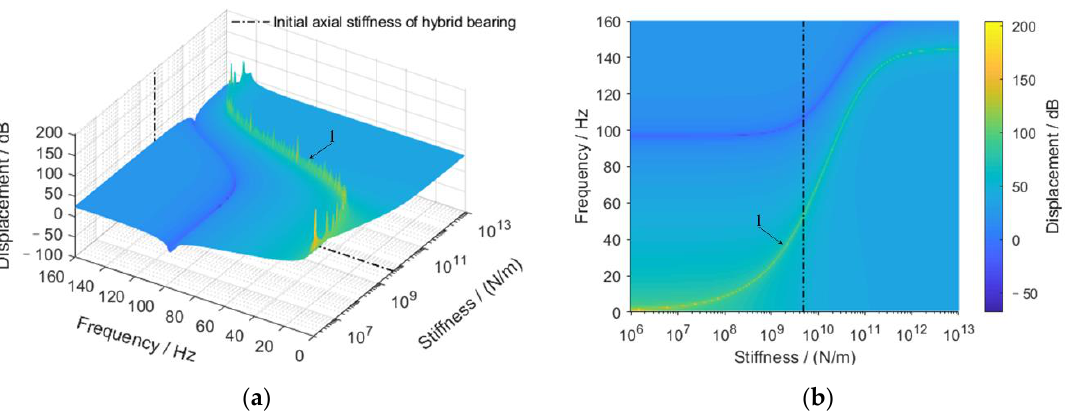
Figure 6. Longitudinal vibration response under different bearings stiffness and frequency. ( a , b ) are the vibration response at x = 0 m. ( b ) is the top view. Numbers and arrows are used to mark the order of the resonance.